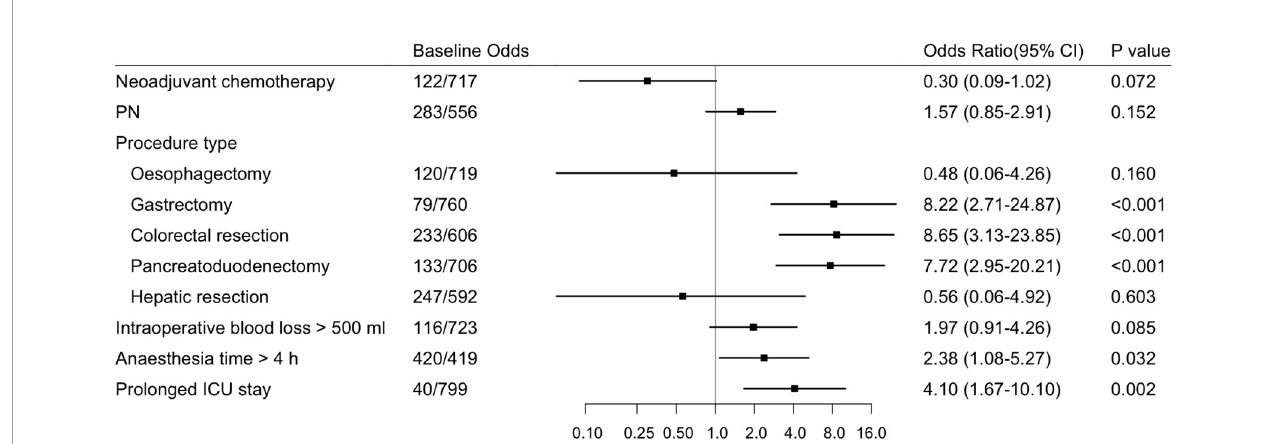
FIGURE 1 | Forest Plot about Risk Factors for Organ/Space Surgical Site Infection (Multivariable Analysis) in Advanced Digestive System Cancer. Odds ratios and 95% CIs are shown, derived from the multivariable logistic regression model (Hosmer-Lemeshow test: P =0.881). CI, con fi dence interval; PN, parenteral nutrition.